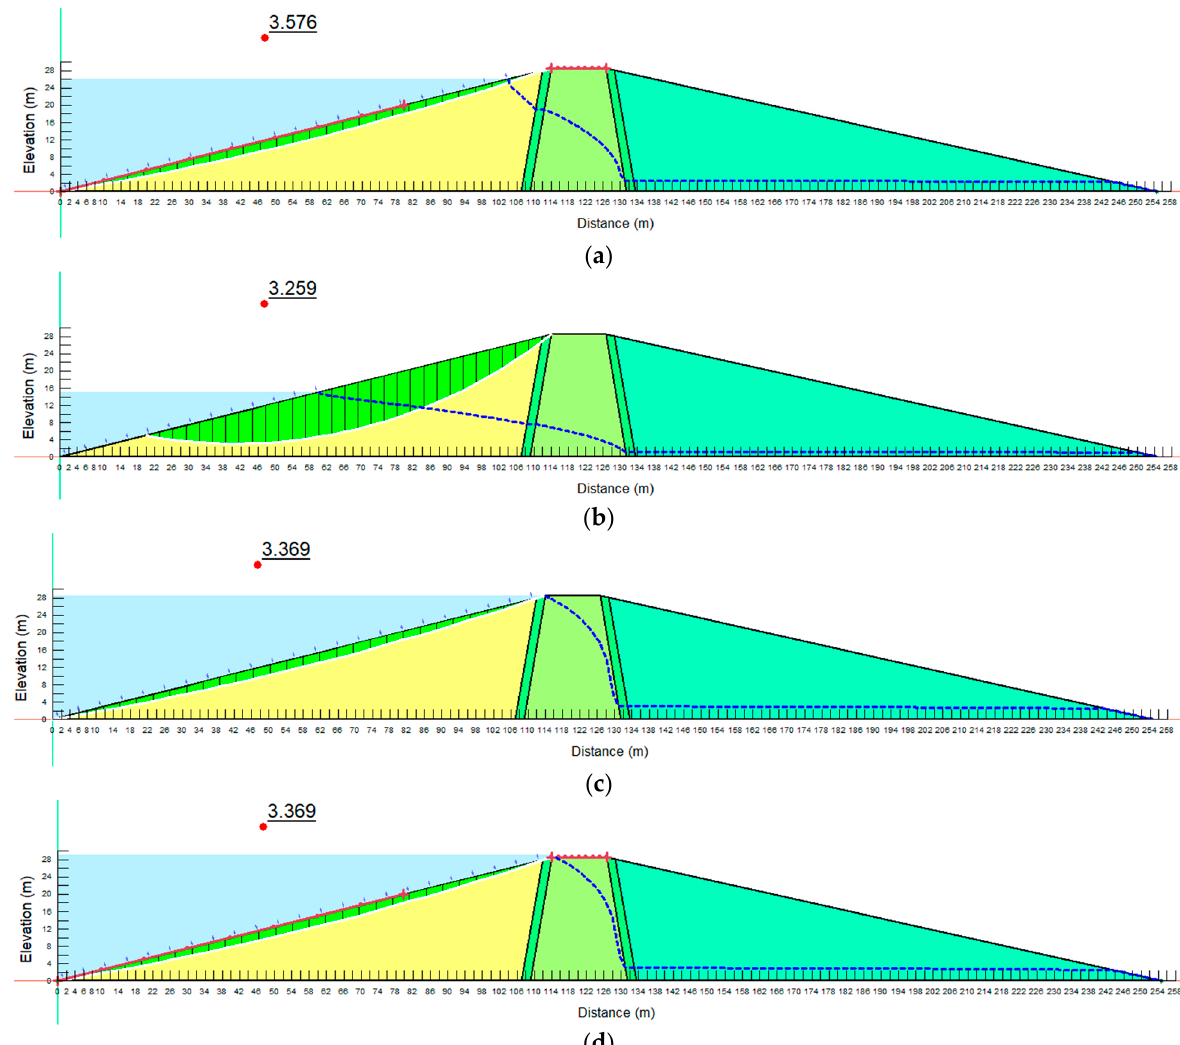
Figure 6. Steady-state slope stability: ( a ) normal operating reservoir level, ( b ) reduced reservoir operating level, ( c ) embankment height reservoir level, ( d ) overflow reservoir level.